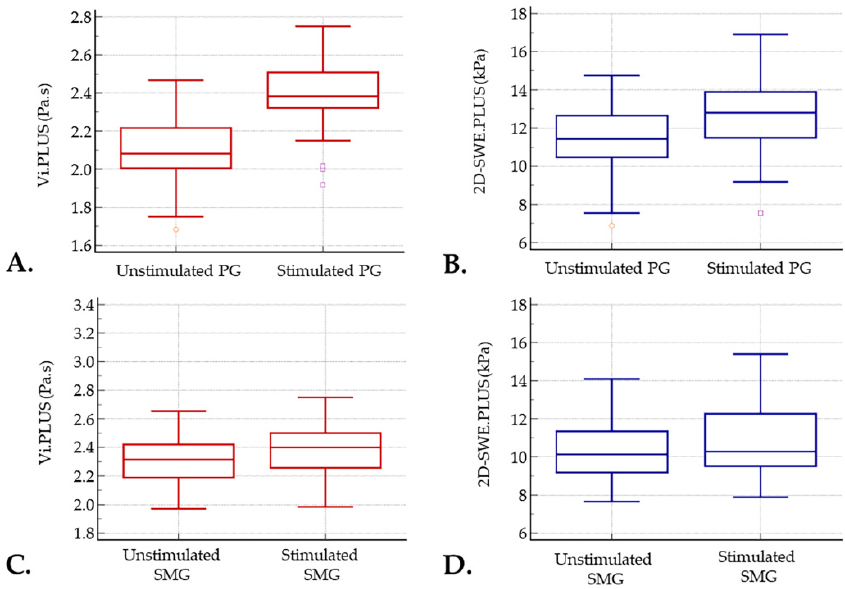
Figure 2. Boxplot showing viscosity ( A , C ) and stiffness ( B , D ) values of parotid glands (PG) and submandibular glands (SMG) before and after stimulation. The 2D-SWE.PLUS values of the PG presented a strong positive correlation with the Vi.PLUS values in basal conditions (r = 0.711, p < 0.001), and after stimulation, respectively (r = 0.676, p < 0.001). The 2D-SWE.PLUS values of the SMG also showed a moderate positive correlation with the Vi.PLUS values in basal conditions (r = 0.646, p < 0.001), and following stimulation, respectively (r = 0.625, p < 0.001) (Figure 3).